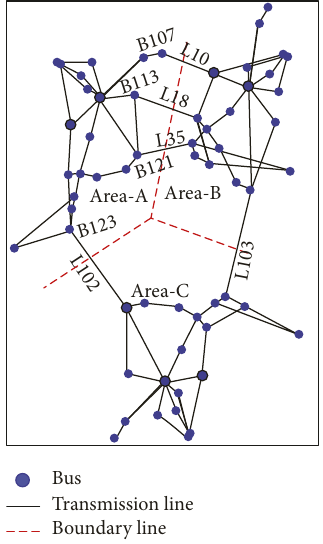
Figure 5: Case study system: reliability test system of grid mod- ernization lab consortium